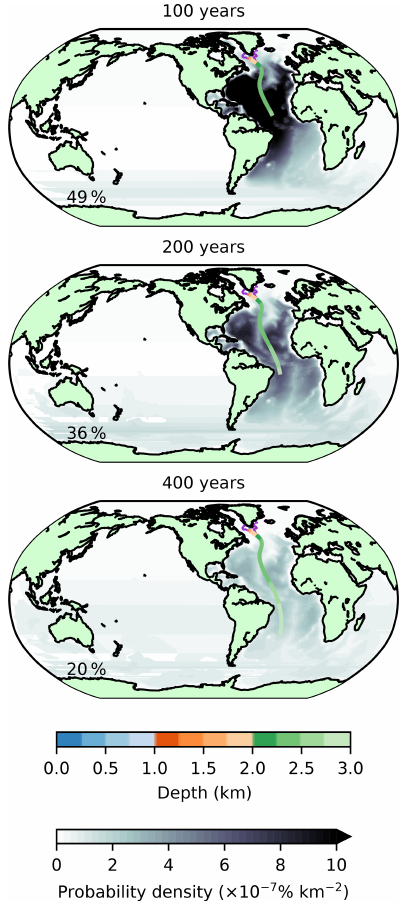
Figure 13. As in Fig. 6 but for subpolar-outcropping model NADW and times of 100, 200, and 400